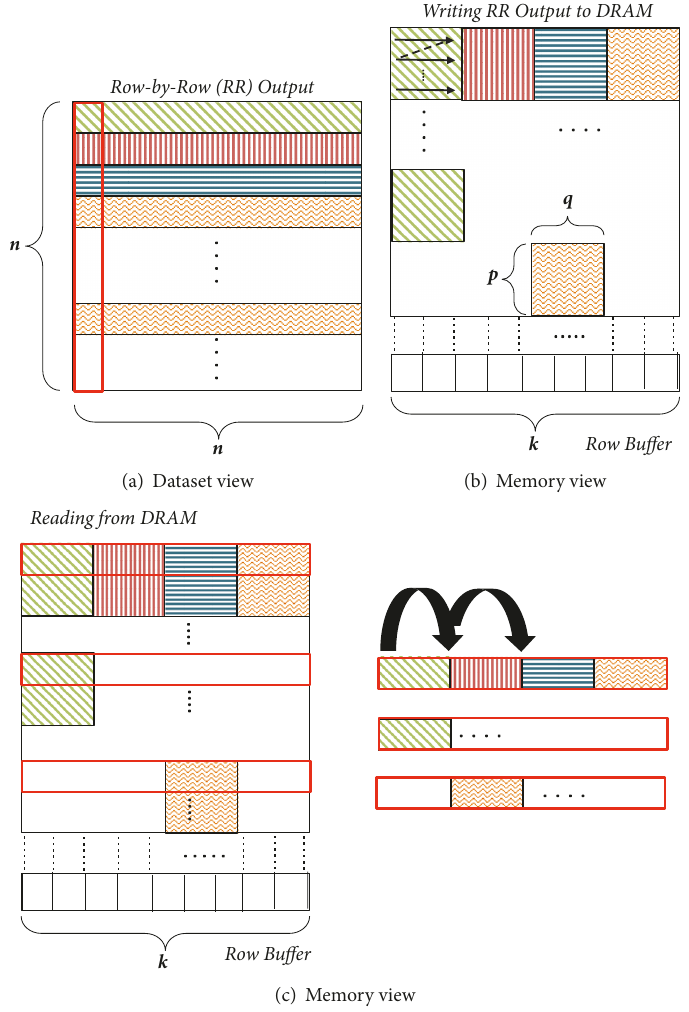
Figure 6: Image showing tile-hopping. (a) Image-level view showing tiles. (b) DRAM-level view showing tile placement while writing. (c) DRAM-level view showing column reading from the tiles.